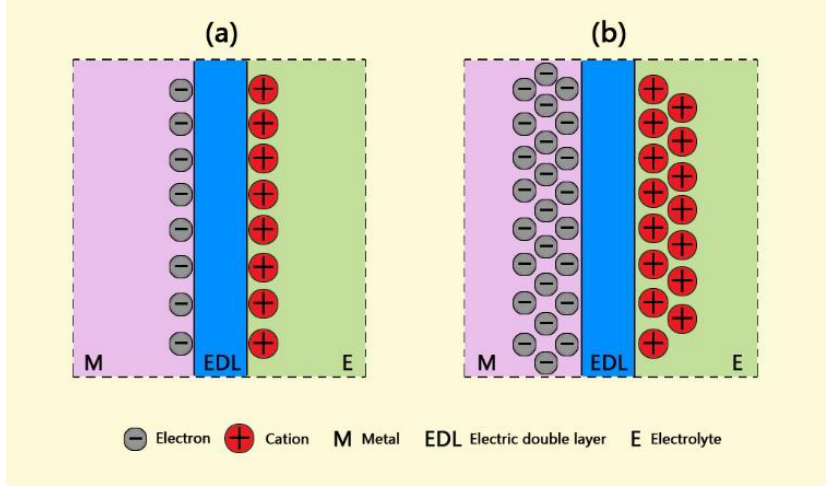
Figure 8. Diagram of an EDL with an equilibrium state of charges ( a ) and a state of applied cathodic current ( b ). Table 7. Maximum values of cathodic current densities of polarization curves under three meas- uring methods in the neutral and alkaline solutions (μA·cm −2 ).